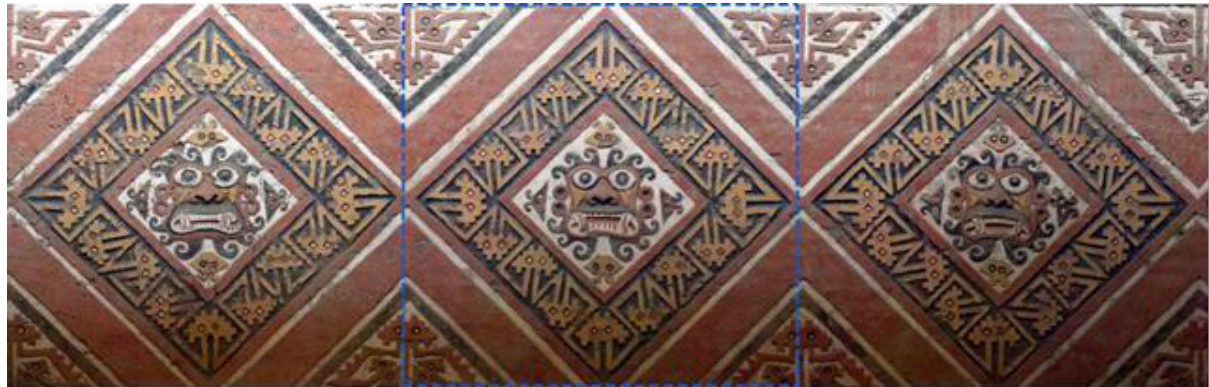
Figure 2. The image represents the orto-rectified image of the bas-relieve using the set of images of 2017. The dashed blue line depicts the portion of the entire surface that has been used for the